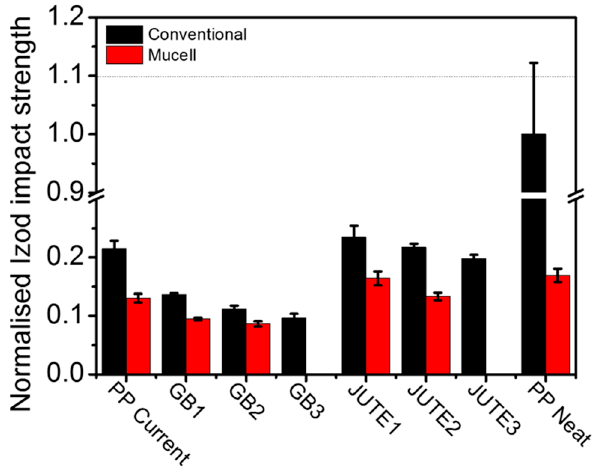
Figure 7. Normalised Izod impact strength of different materials. Note: The data presented were normalised with respect to the corresponding data obtained for conventional injected PP Neat, indicated by the dashed line.